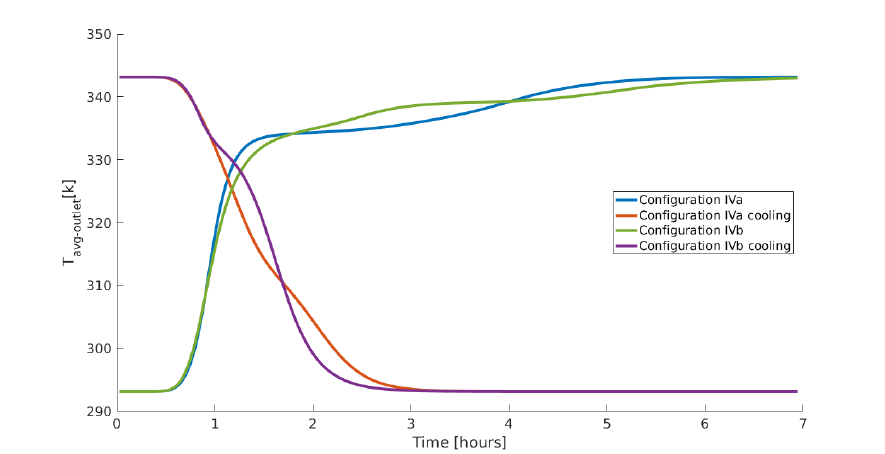
Figure 13. Temperature at outlet for Configurations IVa and